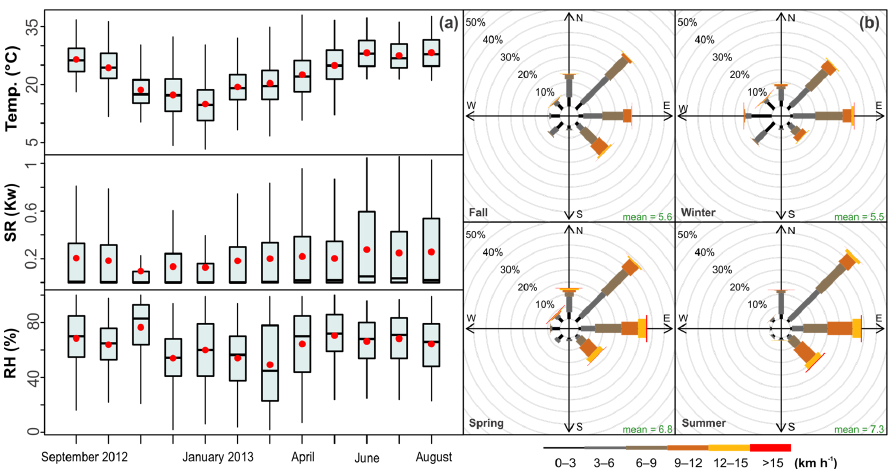
Figure 3. ( a ) Annual profile of the temperature, solar radiation (SR) and relative humidity (RH); ( b ) frequency of the counts of recorded wind direction occurrences at the OBI site during September 2012–August 2013. The horizontal black line shows monthly medians, and the red dots show monthly